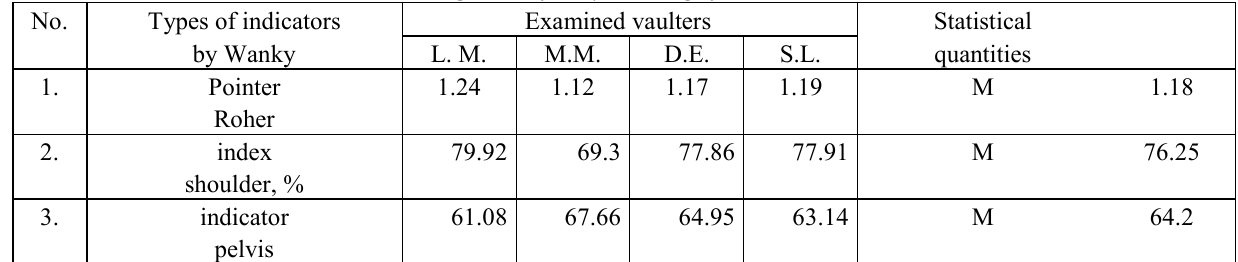
Average rate of body building of the